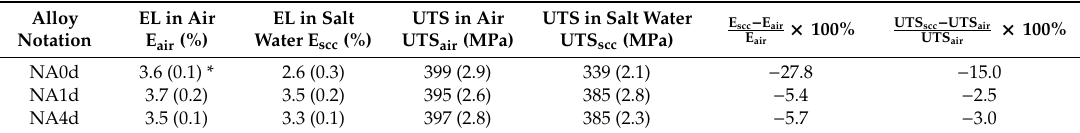
Table 6. Slow strain rate testing results of A201-T7